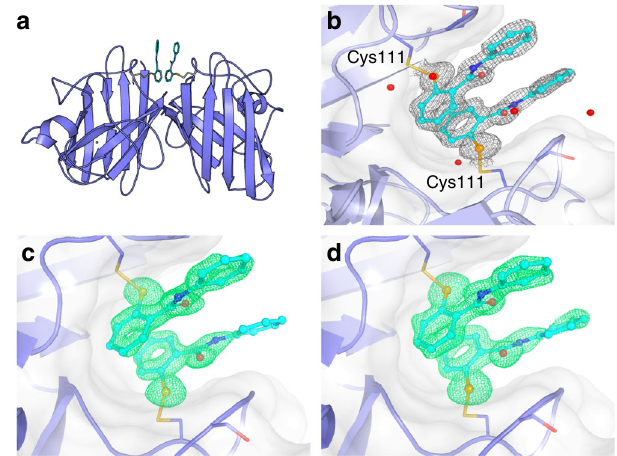
Fig. 1 The structure of ebselen and ebsulphur bound to SOD1. a Cartoon representation of the SOD1 dimer with ebselen or ebsulphur molecules shown as ball and stick and bound to Cys111 residues at the dimer interface. b Electron density map (2Fo − Fc contoured at 1 σ ) showing the pose of two SOD1-bound ebselen molecules and proximal crystallographic waters. Electron density (maps mFo – DFc contoured at 3 σ ) of c ebsulphur and d ebselen showing details of binding at